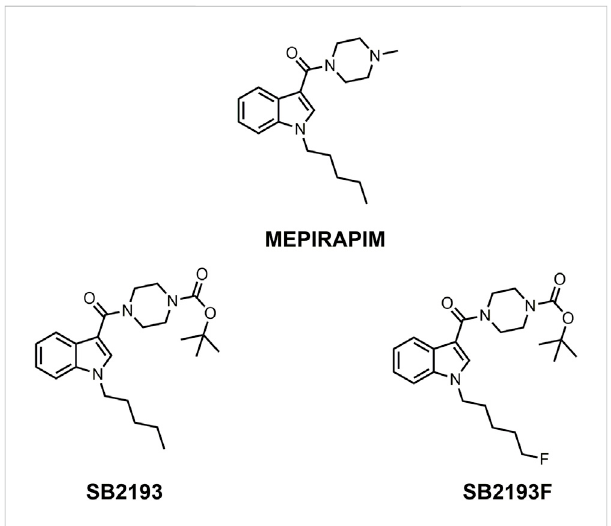
FIGURE 1 Chemical structures of MEPIRAPIM and its